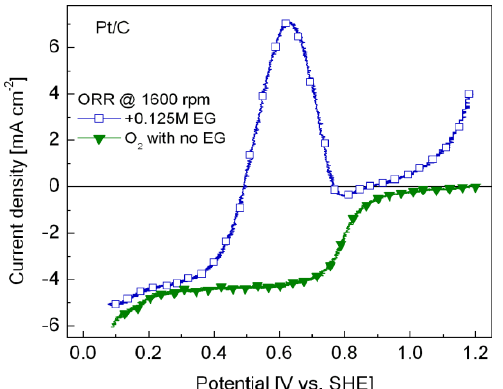
Figure 5. LSV of the ORR in the presence of 0.125 M C 1,600 rpm. Electrolyte: 0.5 M H polarization curve without EG is also